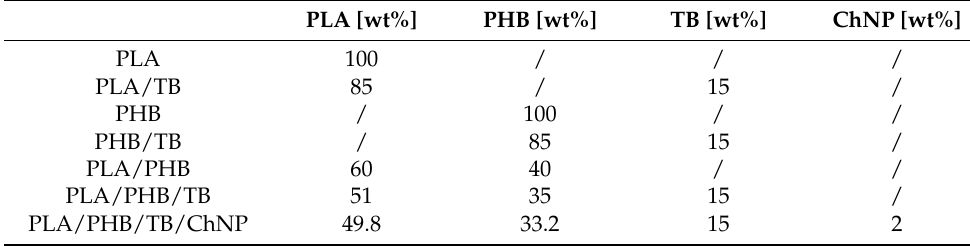
Table 1. Compositions of the obtained